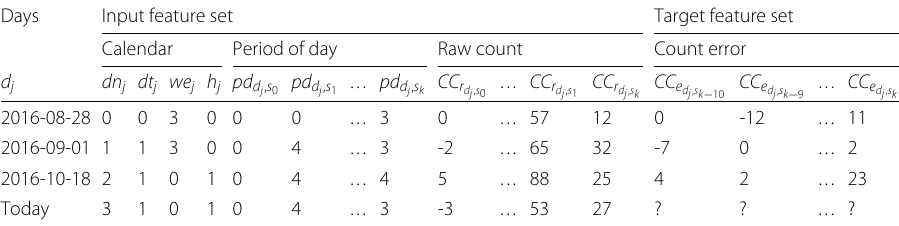
Table 2 Example of a PreCount feature matrix divided into input and target feature